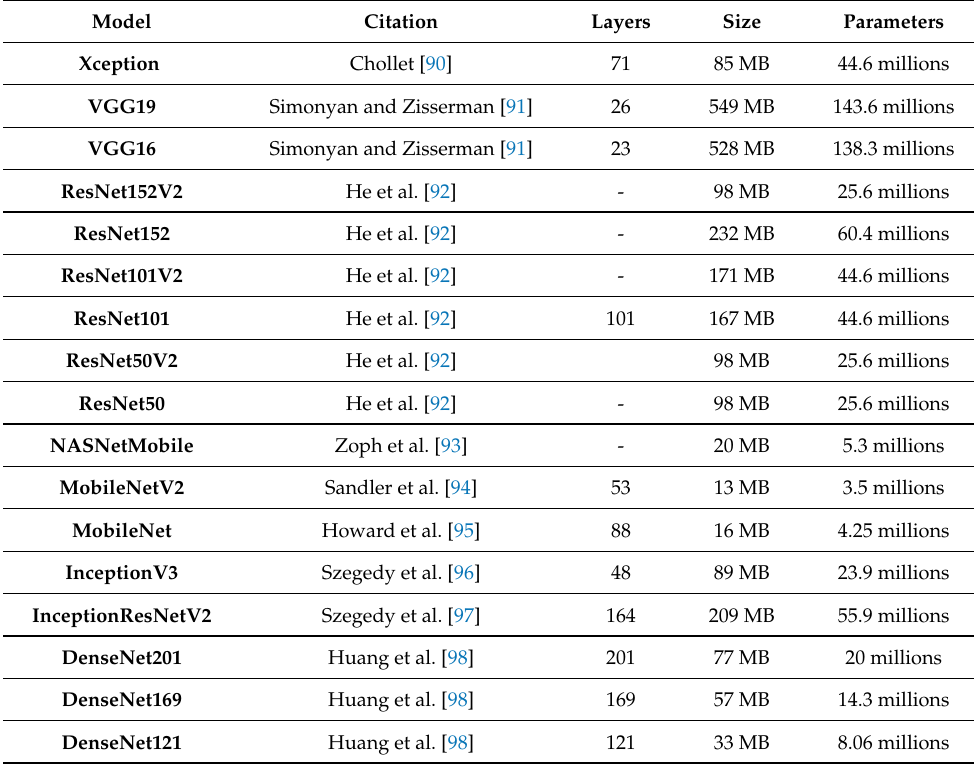
Table 1. Keras pretrained CNN models.